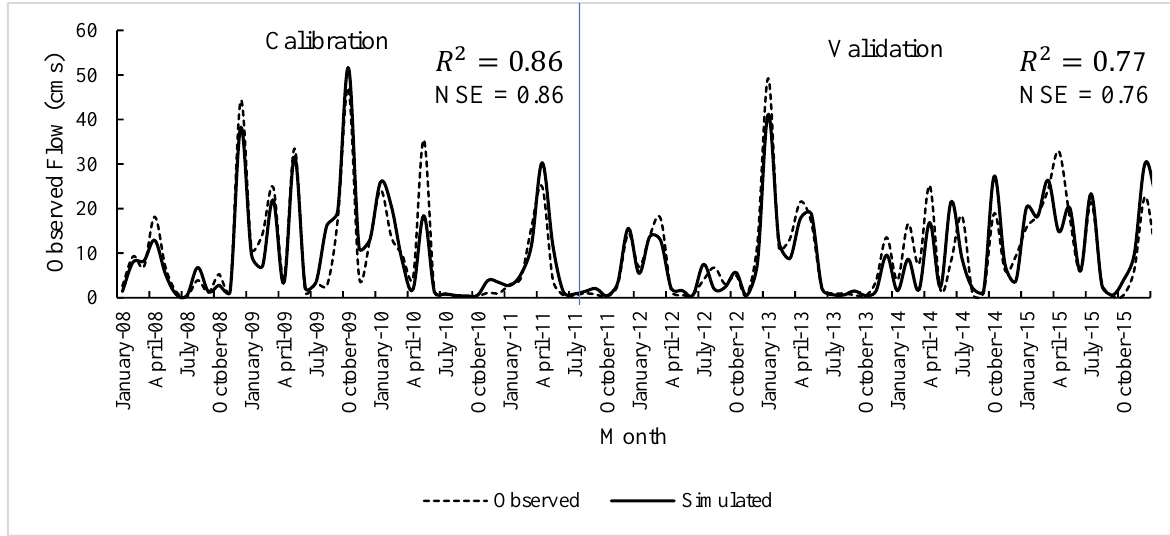
Figure 3. Streamflow calibration and validation Skuna River watershed. Table 2. Calibration and validation results for sediment and nutrient loads.